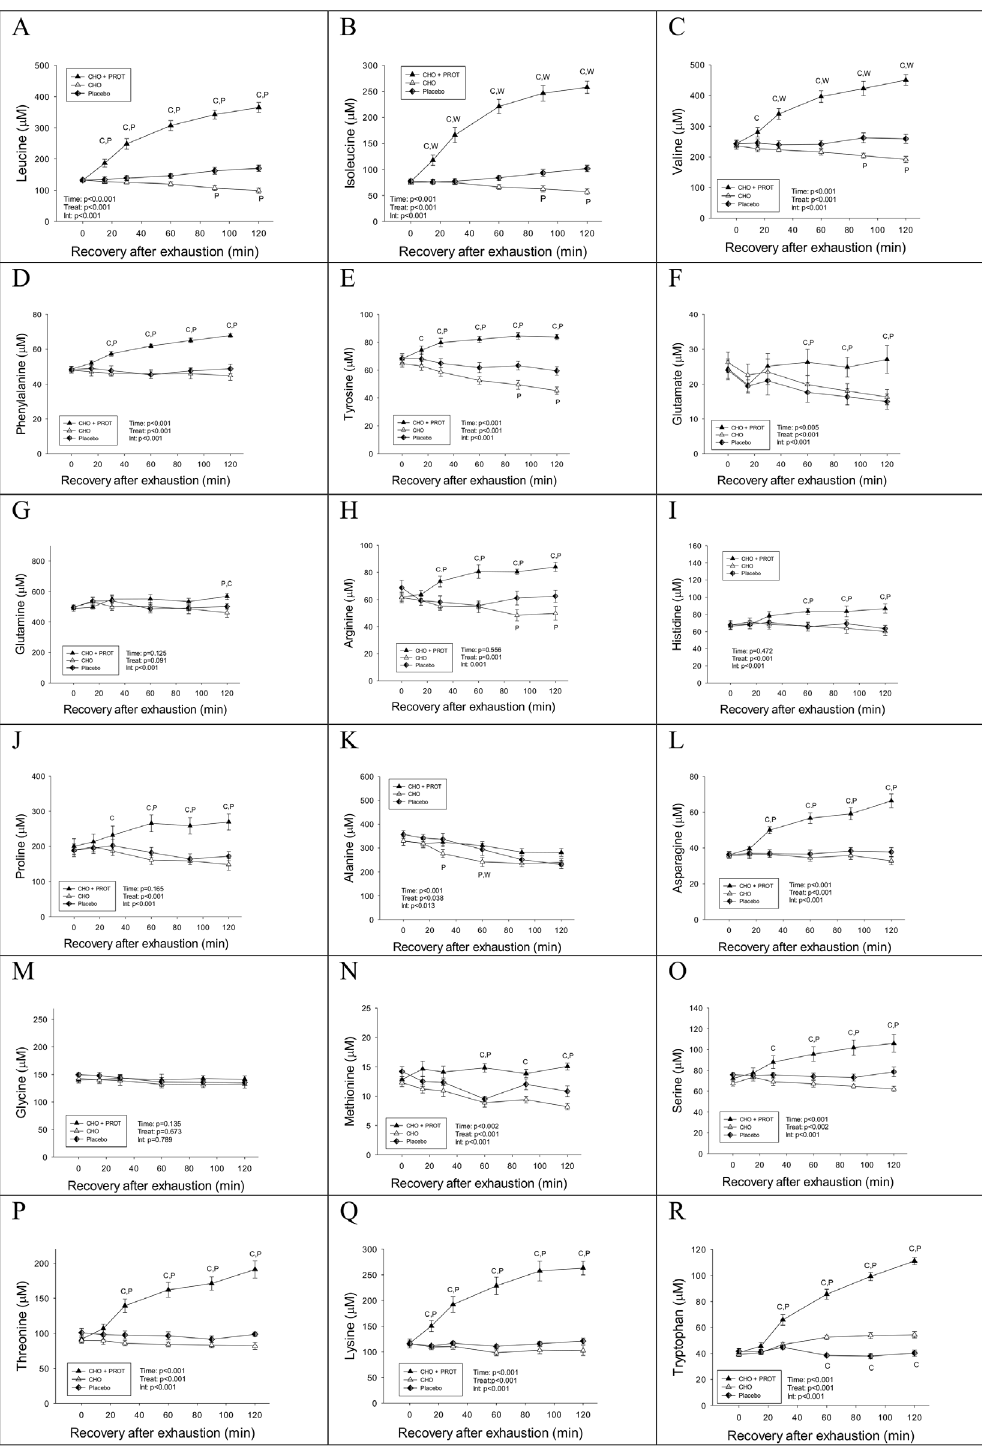
Fig 3. Plasma concentrations of amino acids during the first 2 h of recovery when provided CHO, CHO+PROT or PLA. Data for 18 amino acids are presented; no data are presented on cysteine and aspartate. Data are mean and error bars represents SEM. C: p < 0.05 compared to CHO; W: p < 0.05 compared to CHO+PROT (whey); P: p < 0.05 compared to placebo. N = 8 for all data